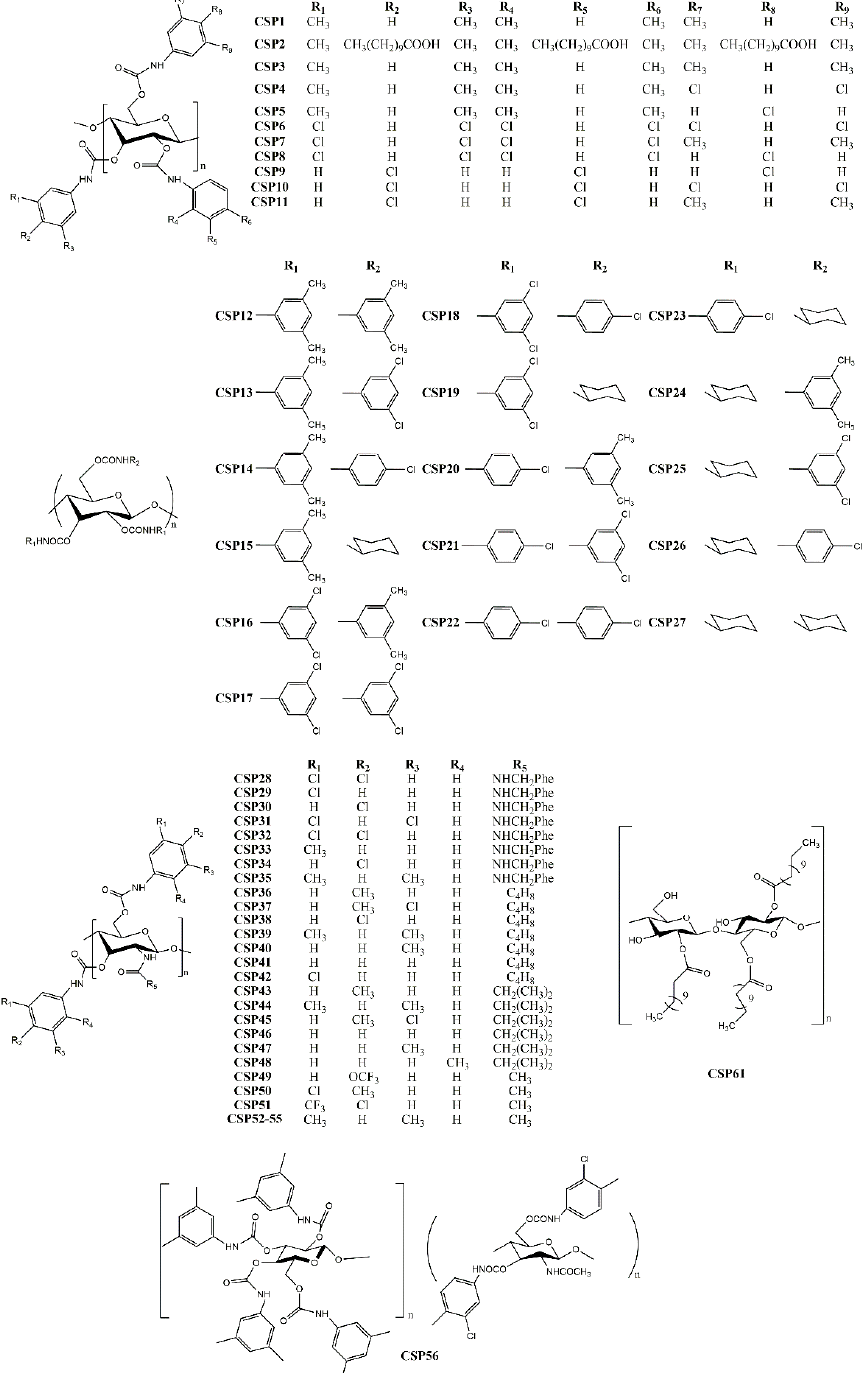
Figure 2. Chemical structures of polysaccharide-based CSP1–56 and CSP61.